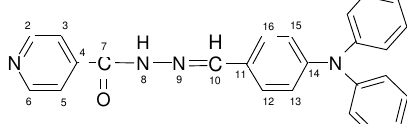
Figure 1. Isonicotinoylhydrazone-4-diphenylaminobenzaldehyde (INHDAB =